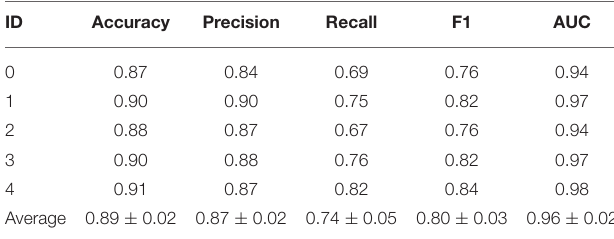
TABLE 5 | Performance of DL model and senior doctor in identifying non-perfusion area